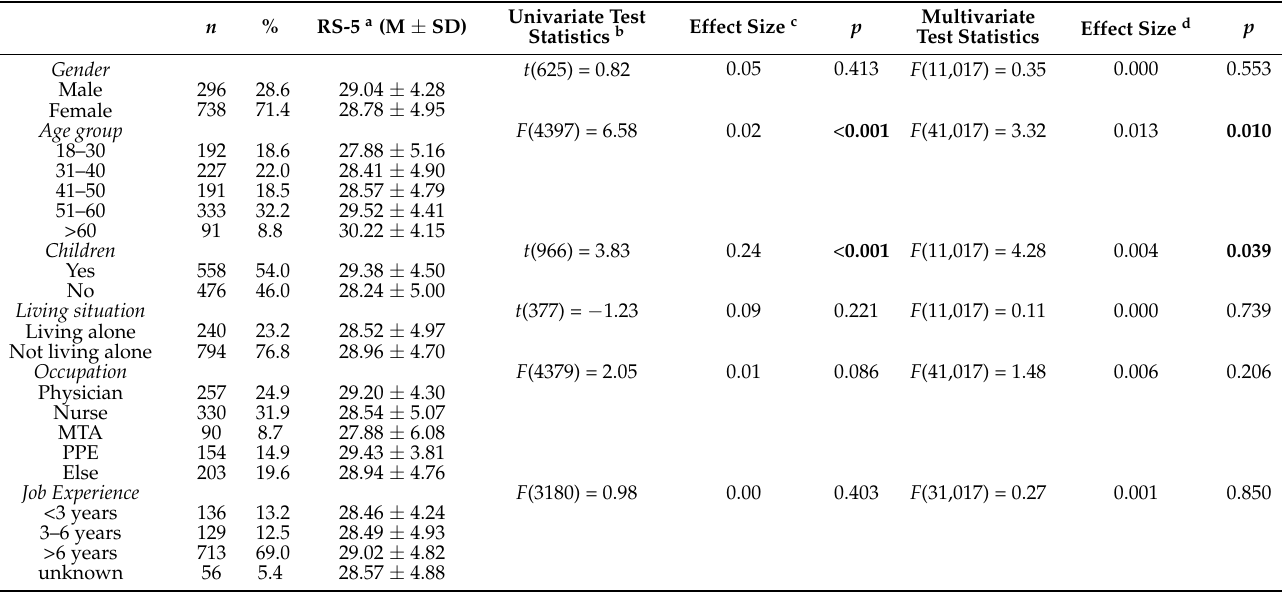
Table 1. Descriptive statistics on demographics and occupation and differences in resilience levels ( N =